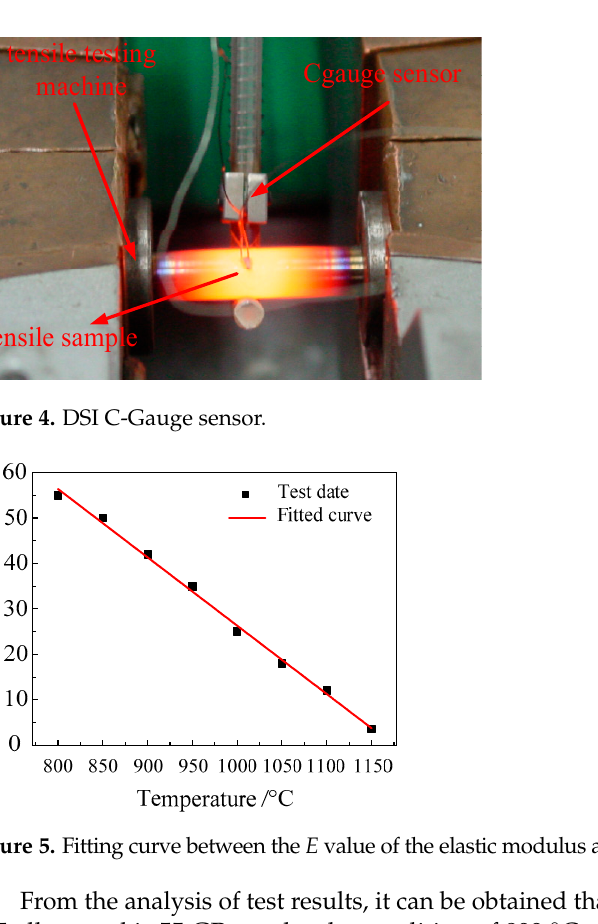
Figure 6. Comparison of the damage parameter S values of Cr5 alloy steel with different elastic moduli.